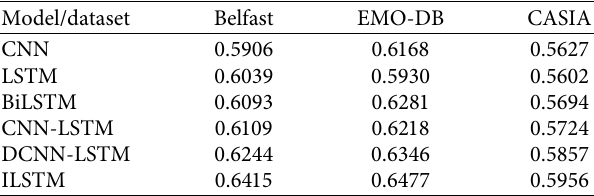
Table 9: F1 of different models on each dataset.